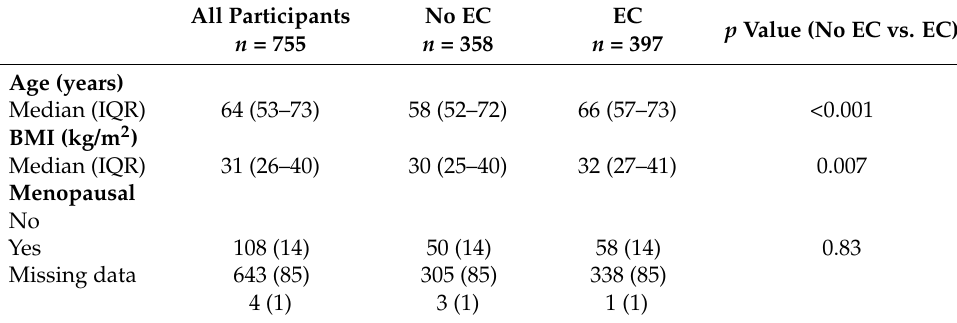
Table 1. Characteristics of study population.